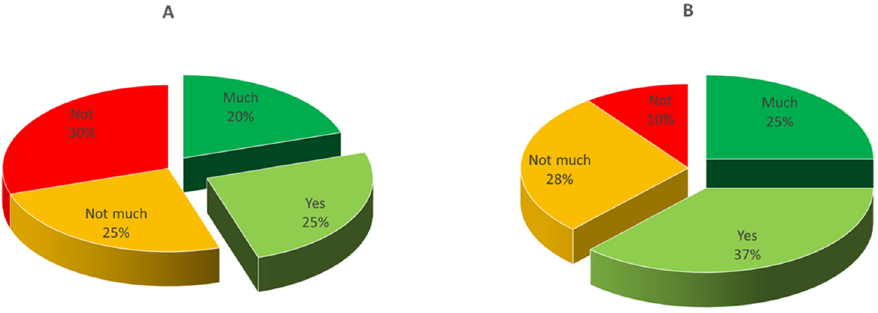
Figure 4. Results of consumer testing of the cheese samples from trials ( A , B ) at 1 day. Overall liking levels (%) are reported in the pie chart. Not = not appreciated (score 0); Not much = not much appreciated (score 1); Yes = appreciated (score 2); Much = much appreciated (score 3).